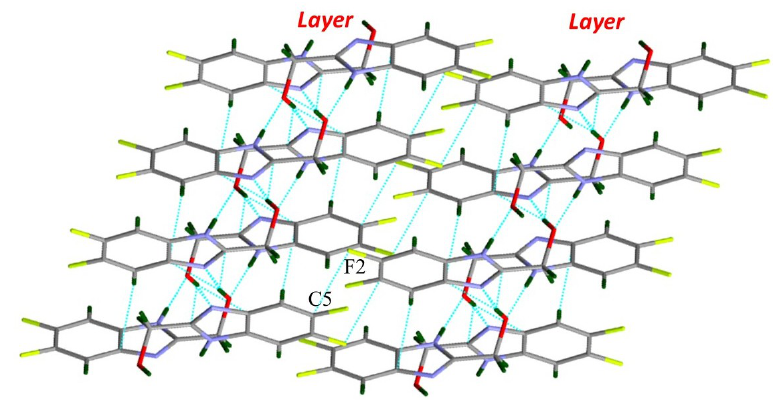
Figure 5. Assembling of layers via C5…F2 interactions in the structure of 1d .